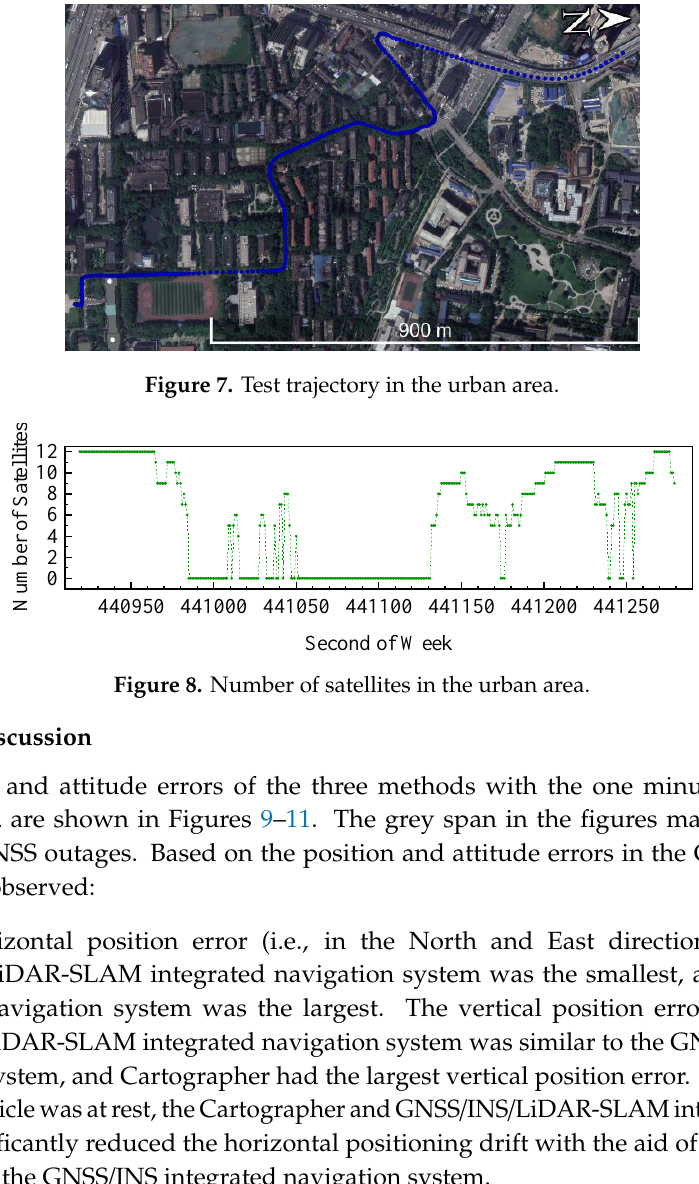
Figure 6. Test trajectory in the open-sky environment.